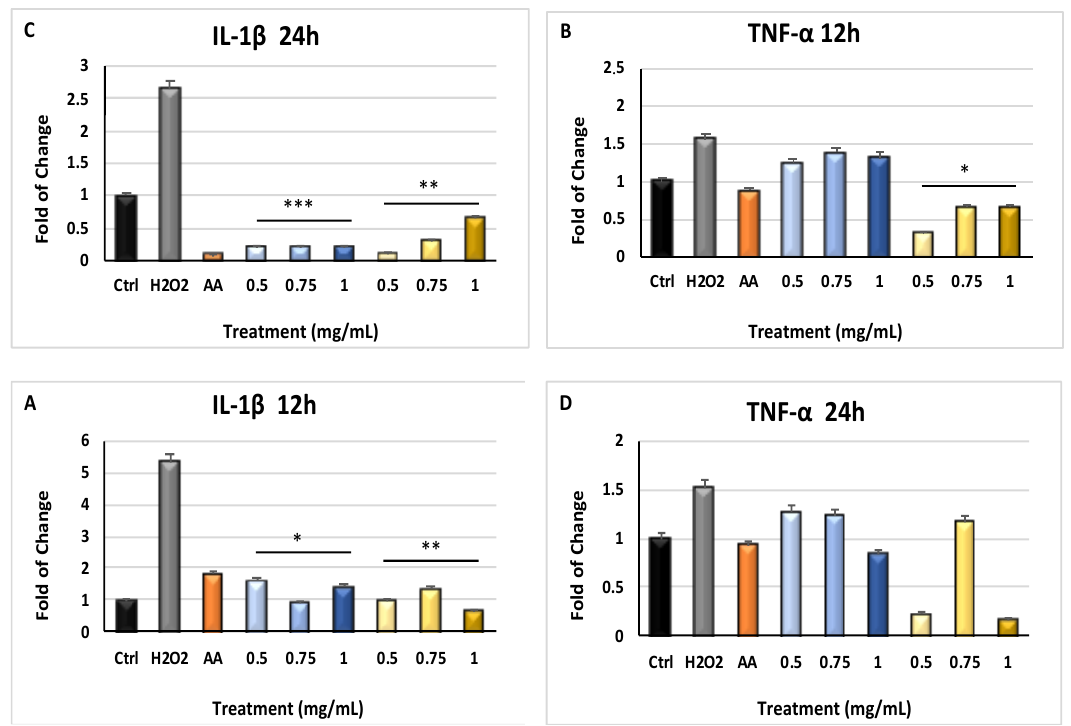
Figure 2. Gene expression of proinflammatory cytokines IL-1 β and TNF- α . The expression of Interleukin 1 beta (IL-1 β ) and Tumor necrosis factor alpha (TNF- α ) was evaluated in cells pre-treated with the extracts for 12 h and 24 h and then exposed to H 2 O 2 (Panels ( A ) and ( B ), and panels ( C ) and ( D ), respectively). HFF1 were exposed to ascorbic acid (AA, orange bar), or to 0.5, 0.75 and 1 mg / mL seeds waste extracts (blue bars) or 0.5, 0.75 and 1 mg / ml pulp waste extracts (yellows bar). H 2 O 2 (grey bar) represents HFF1 cells exposed to only H 2 O 2 , without previous extracts treatment. The mRNA levels for each gene was expressed as fold of change (2 − ∆∆ Ct ) of mRNA levels observed in untreated HFF1 (CTRL, black bar) defined as 1 (mean ± SD; n = 6) and normalized to Glyceraldehyde-3-Phosphate-Dehidrogenase (GAPDH). Data are represented as mean ± SD referred to the control (* p ≤ 0.05, ** p ≤ 0.01 and *** p ≤ 0.001).